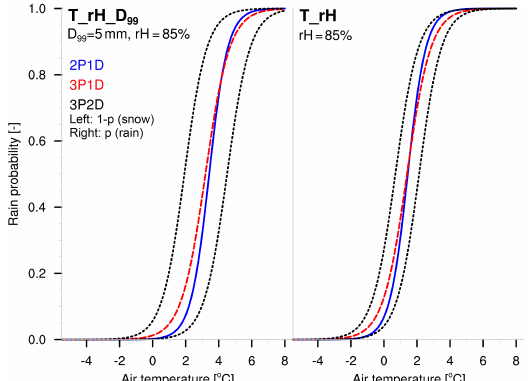
Figure 11. Air temperature versus predicted PP by the different methods: two PPs (2P1D; solid blue), three one-PP distributions (3P1D; dashed red), and three two-PP distributions (3P2D; dot- ted black). 3P2D consists of two curves (left: snow distribution as 1 − p (snow); right: rain distribution as p (rain)) for the calculated coefficients of T _rH_ D 99 (left panel; rH = 85%, D 99 = 5mm) and T _rH (right panel; rH = 85%).